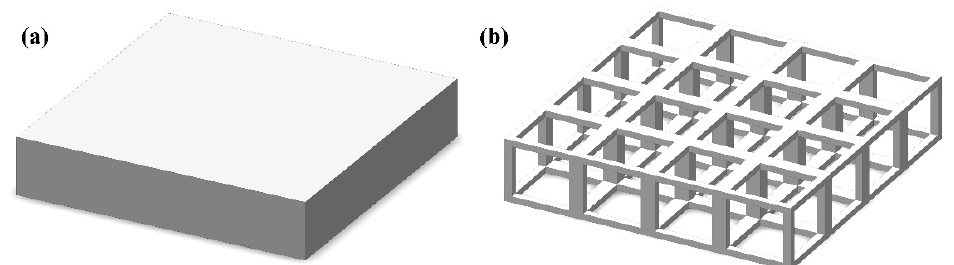
Figure 1. ( a ) Silver plate; ( b ) periodic cubic frame silver structure.